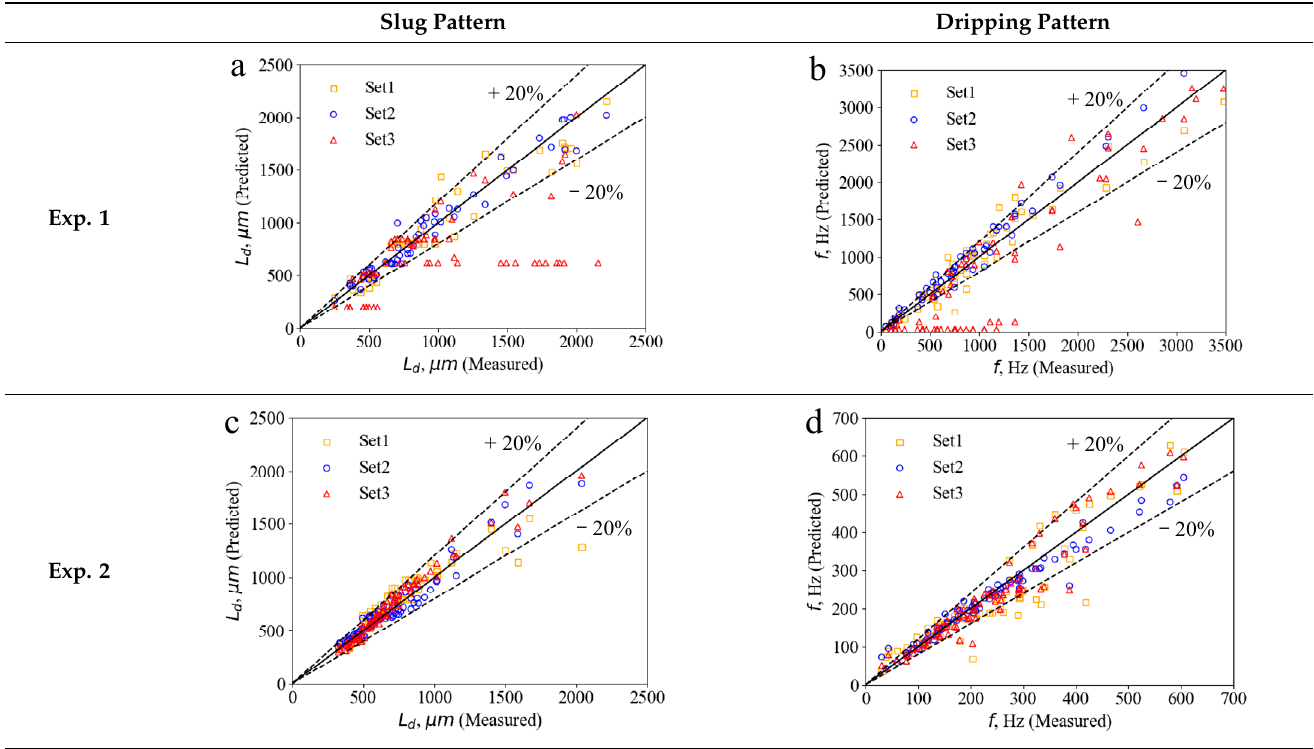
Table 6. Model errors of slug and dripping patterns predicted by three sets in Experiment 1 and Experiment 2, ( a ) L d in